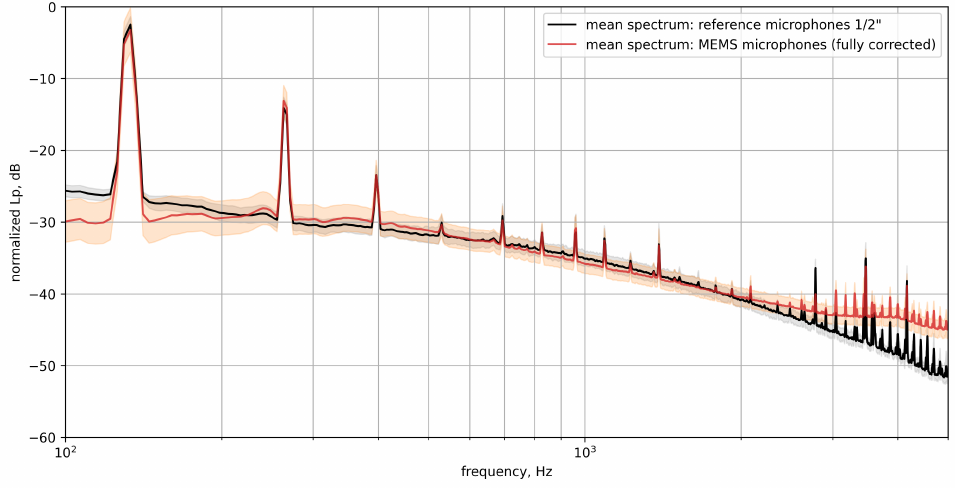
Figure 14. Comparison of the mean spectra of the MEMS microphones and the reference microphones with standard